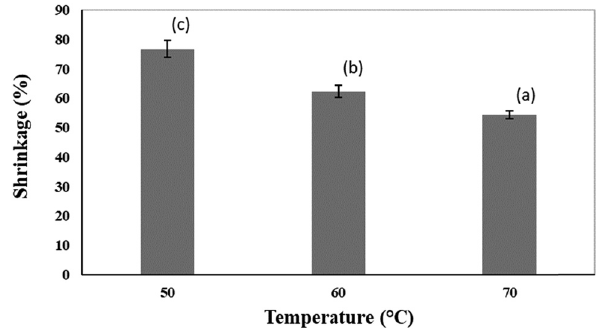
Figure 10: Shrinkage of dried pomegranate arils in CV dryer. The bars represent mean values and the corresponding standard deviations. Bars with the same letter are not signi fi cantly di ff erent according to ANOVA and Tukey test ( p < 0.05 ) .